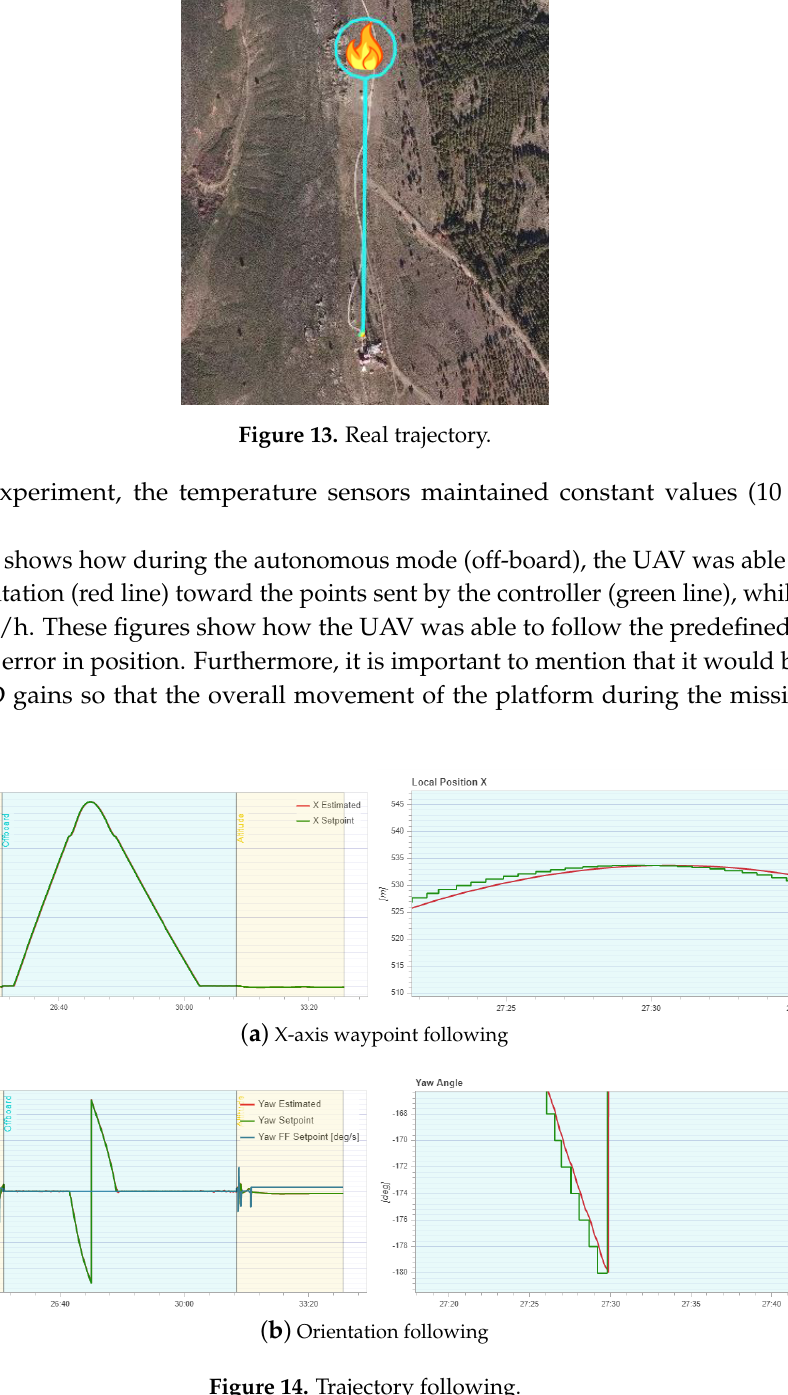
Figure 14. Trajectory